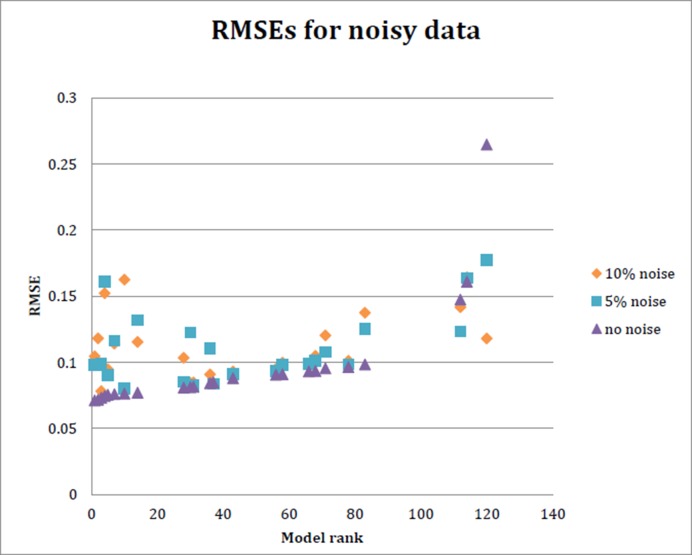
RMSE for each of 24 models run with data simulating 5% noise and 10% noise.Ten datasets were generated to randomly introduce 5% or 10% noise, respectively, into the input data. The model was then fit on each of these noisy datasets as before, and the average RMSE obtained from the 10 datasets at 5% noise and 10% noise is plotted here, as well as the RMSE obtained with initial model fitting..